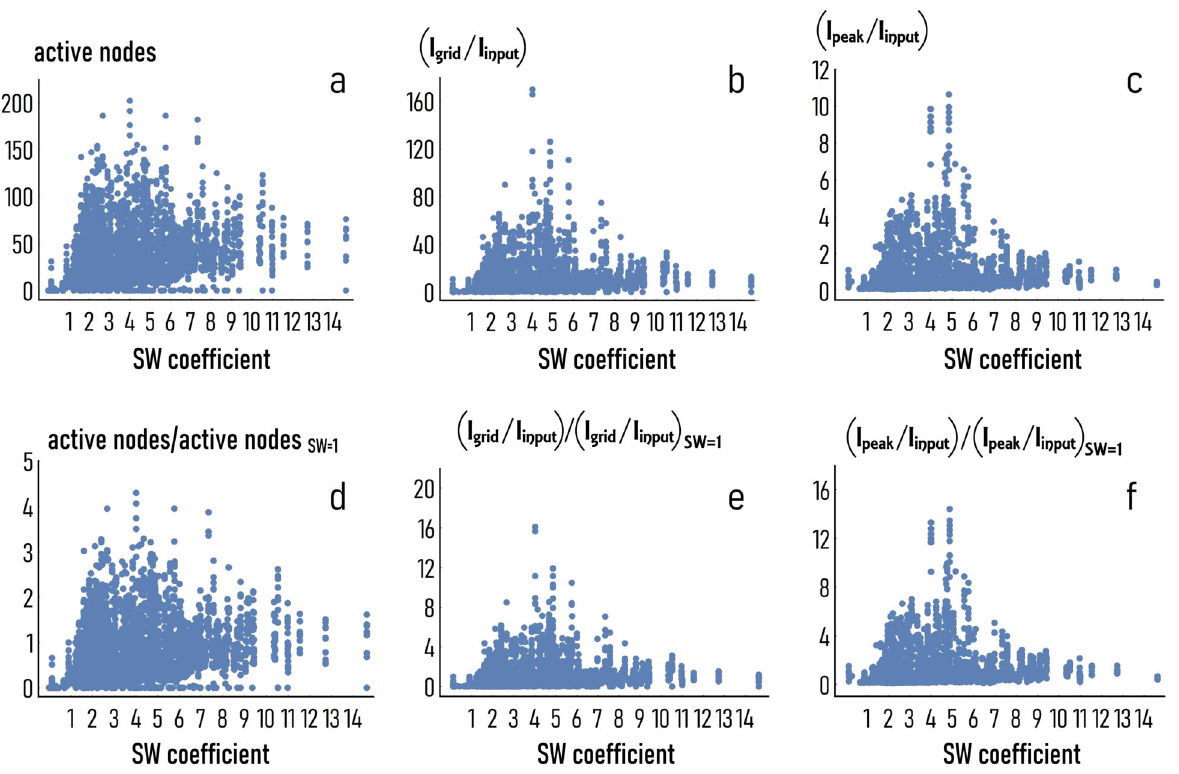
Fig. 2 Applying repeatedly a random signal to nodes of the networks, we produced a disturbance that traveled in the system with a pace and amplitude that depended on the networks ’ topology. To quantify the effect of small-world-ness on the information transported by the disturbance, we measured for each network topology ( SW ) the number of nodes reached by the signal (active nodes, a ), and the total ( I grid = I input , b ) and the peak information ( I peak = I input , c ) in the network, compared to the same values associated to the initial stimulus. Then, we found how the number of active nodes ( d ), the normalized total ( e ), and peak information ( f ) behave relative to the values of these system ’ s variables determined for the special case SW ¼ 1 . The ratios reported in the insets d – f represent enhancement factors ( η nodes , η grid , η peak ) and indicate how much the information fl ows in the network are enhanced due to the network topology. These diagrams were determined for a length and frequency of the initial stimulus of 4 t ¼ 72ms and f ¼ 133Hz